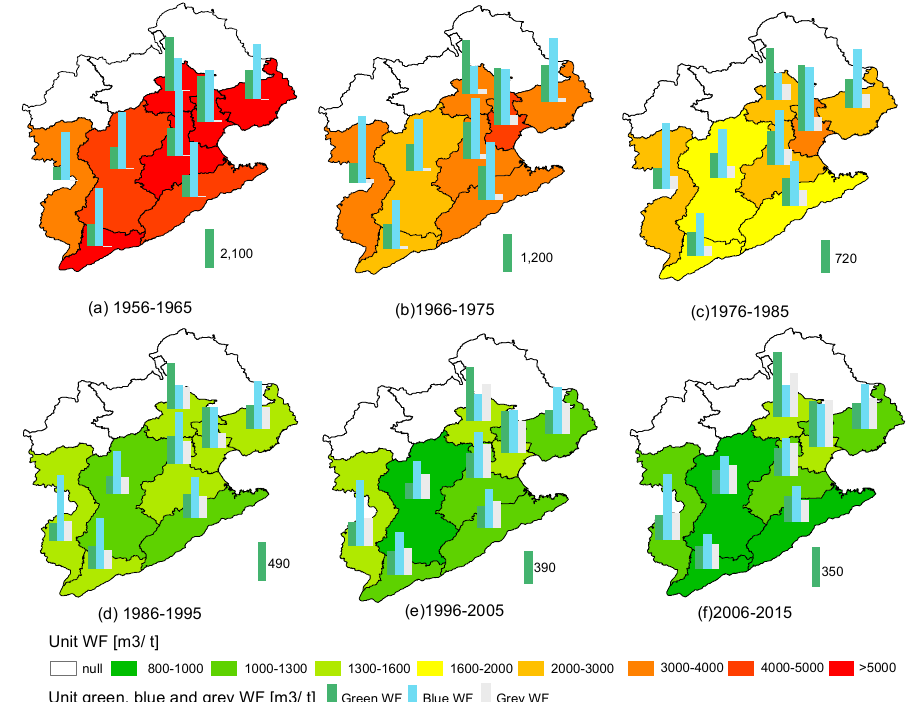
Figure 6. Unit WF of wheat in the HRB over 1956–2015 (m 3 t –1 ).